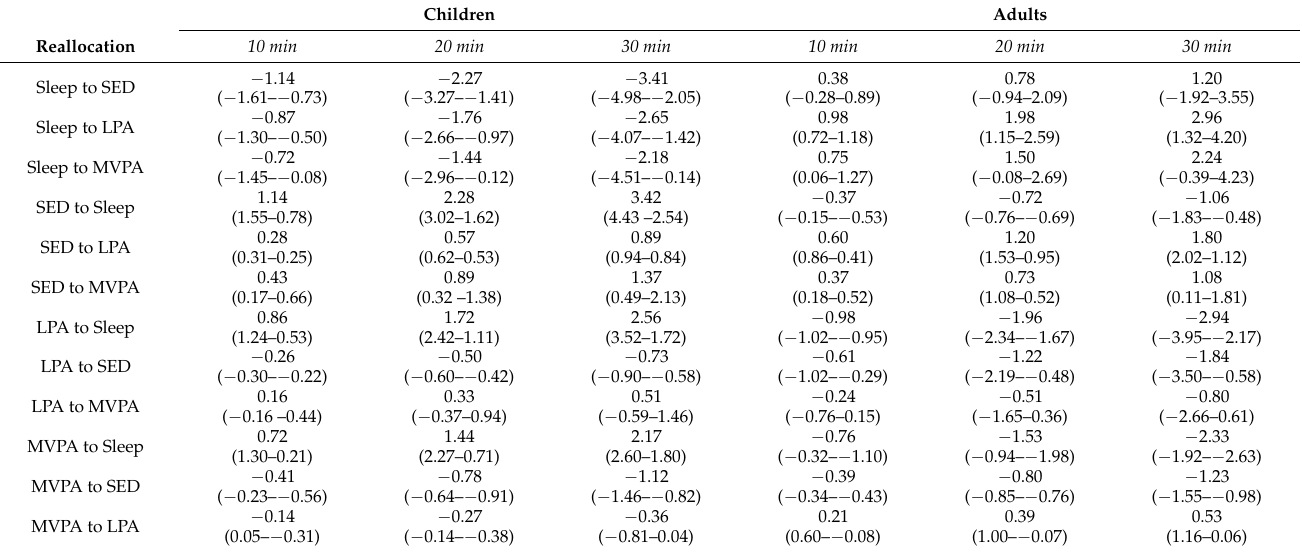
Table 4. Changes in FEV 1 % predicted when reallocating time amongst different movement behaviours from the non-adjusted model in children with CF.